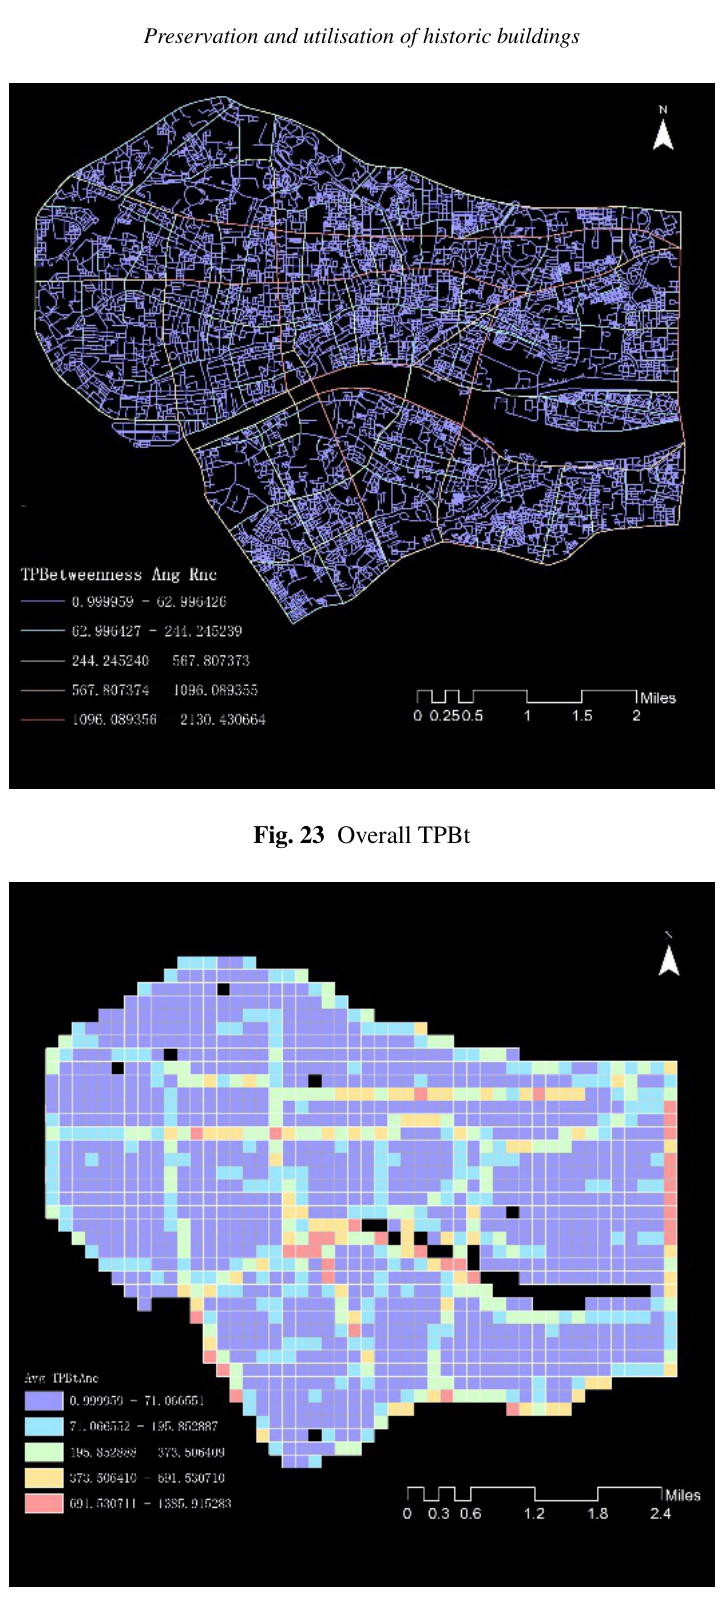
Fig. 24 Fishing net graph of overall